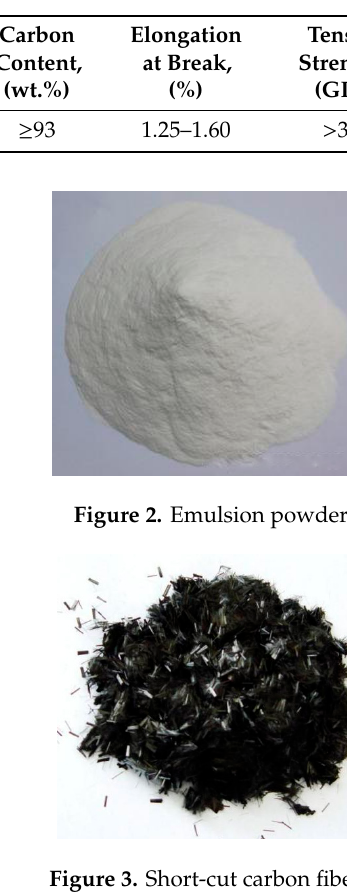
Table 2. Main indexes of carbon fiber.